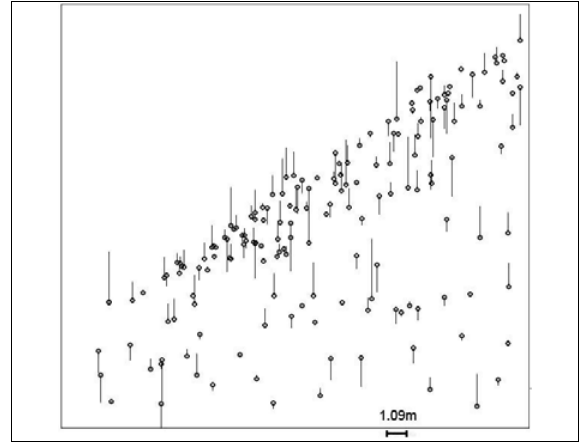
Figure 5. Discrepancies at control points in Z, b/h =